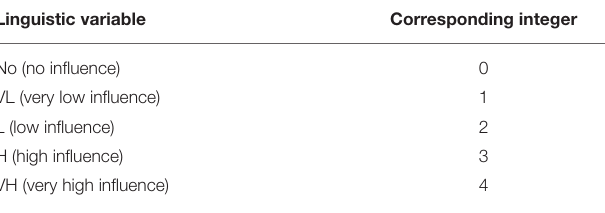
TABLE 2 | Conversion between linguistic variables and integer rank.